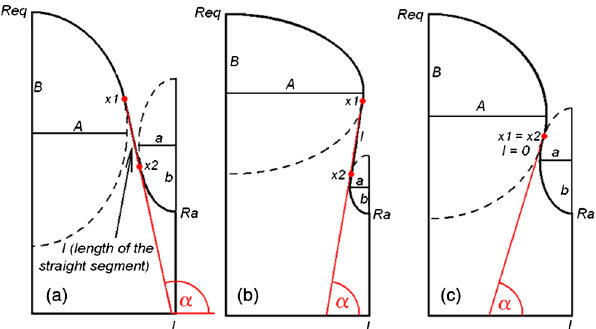
mm.FIG. 1. Geometry of the elliptic half-cell: (a) nonreentrant, and (b),(c)